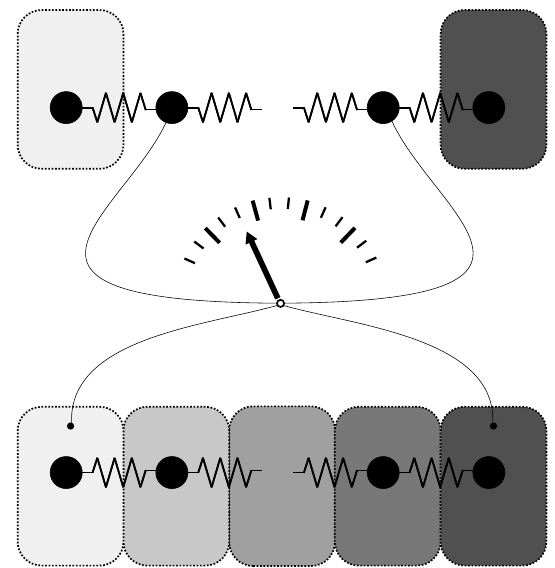
Figure 1: Illustration of constructive vs. self-consistent approaches to heat conduc- tion in temperature gradients. In the former heat flows from the hot reservoir to the cold one through the oscillators. It former draws its motivation in the derivation of the physics of open systems from that of isolated systems (micro-to-meso / scopic); its dissipative observables are the temperatures of the bulk oscillators. In the lat- ter heat flows to and from each reservoir. This approach focuses on the tempera- ture of the baths, and aims to connect to broad-scale energy consumption (meso-to- macro /